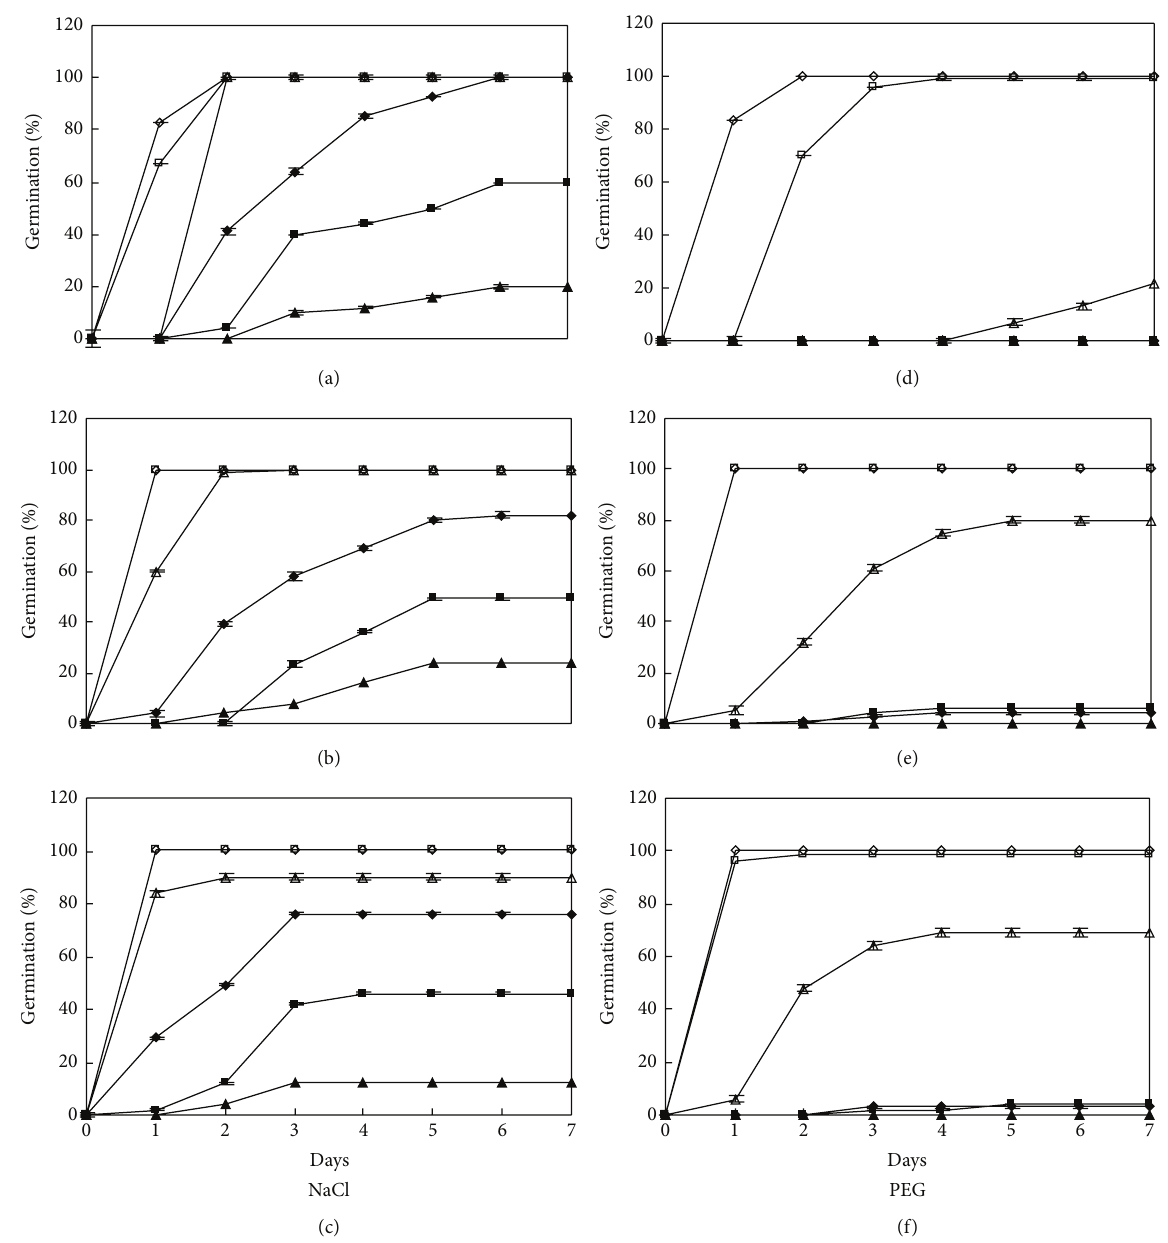
Figure 3: Germination time courses of LK in NaCl and PEG solutions at alternating temperature regimes. See Figure 1 for symbols.